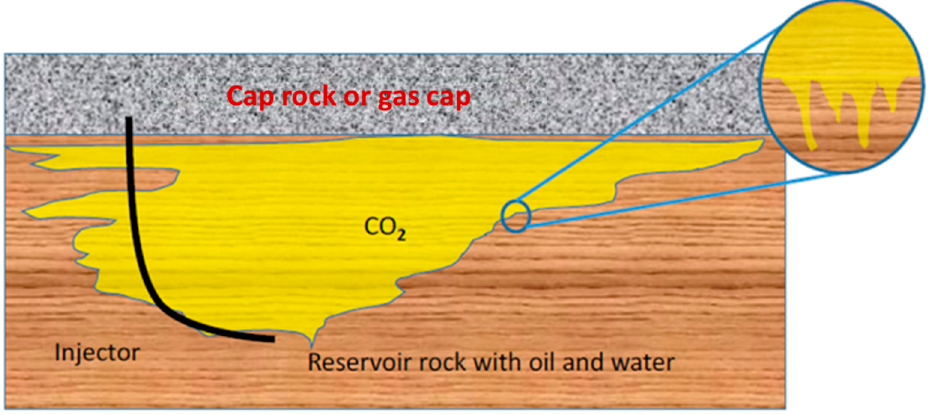
Figure 1. Simplified sketch of convection-driving dissolution of CO 2 with oil inside the reservoir.